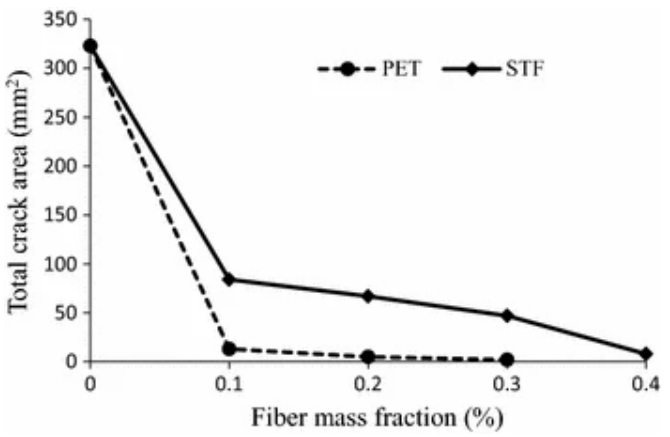
Figure 7. Maximum crack width and total crack area in specimen for STF and virgin PET fibers [42].